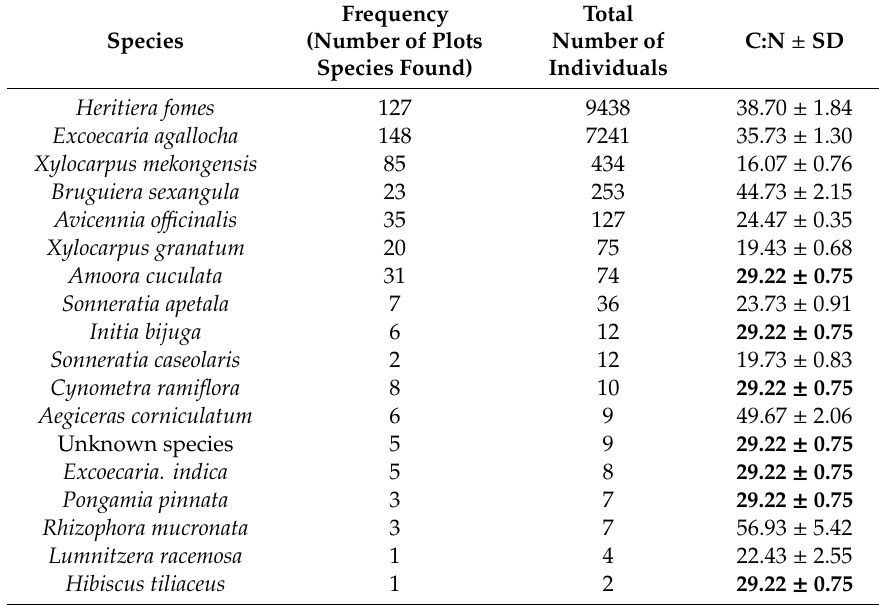
Table 1. Species-wise mean leaf carbon to nitrogen (C:N) ratio ( ± SD) with the relative abundance of species. Bold-type C:N values (for missing trait value of species) were mean trait value for all species measured by Chanda et al. [13], and SD were calculated from the three seasonal values. The relative abundance of species was based on live trees have DBH ≥ 10 cm (2009–2010) forest inventory data of 150 plots Rahman et al. [16].